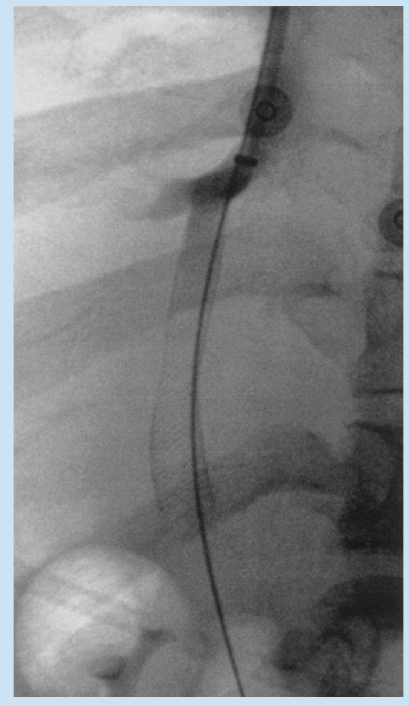
Fig. 1b. Following TIPSS creation, a self-expand- ing wallstent has been used to maintain patency of the parenchymal tract between the right hepat- ic vein and the right portal vein.